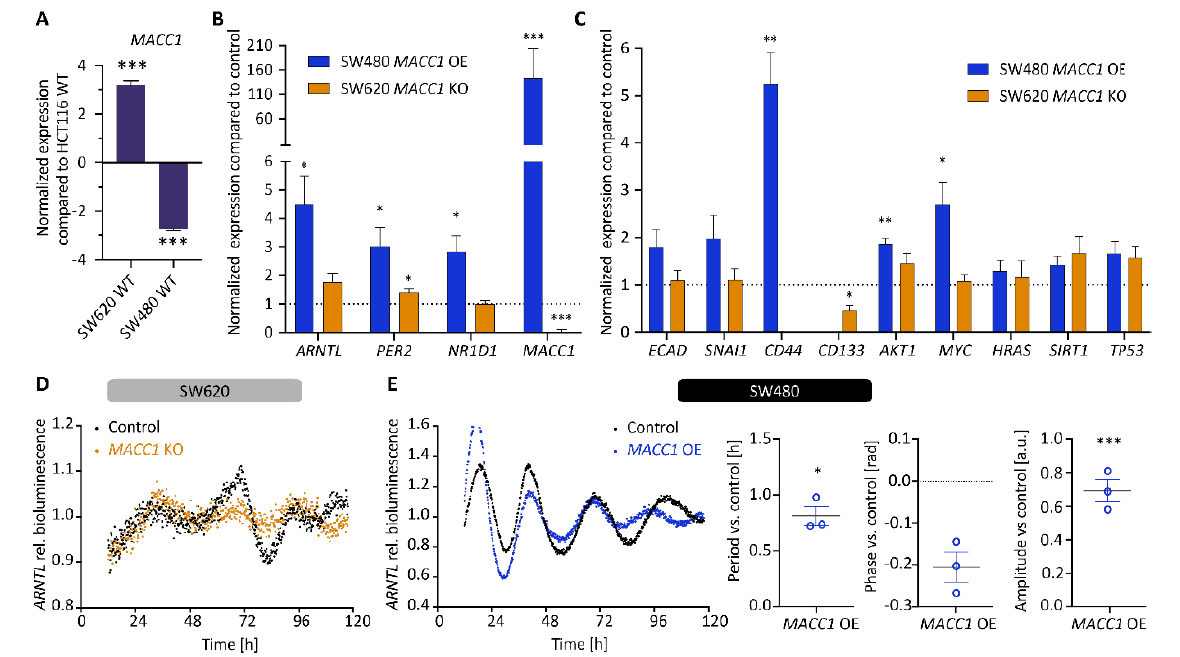
Figure 4. MACC1 manipulation in SW480 and SW620 cell lines leads to differential expression in clock and EMT-related genes ( A ) Analysis of MACC1 expression between HCT116 WT, SW480 WT and SW620 WT ( n = 3, mean ± SEM). Gene expression analysis of core-clock genes ARNTL , PER2 and NR1D1 ( B ) as well as related genes in EMT, cell cycle, death and metastasis ( C ) in SW480 MACC1 overexpressing (OE) and SW620 MACC1 knockout (KO) cells, respectively. Samples were collected at 24 h after synchronization. Each condition was compared with its respective control cell line. ( n = 3, mean ± SEM). ( D , E ) ARNTL -promoter activity in SW620 MACC1 knockout ( D ) and SW480 MACC1 overexpressing ( E ) cell lines compared with the respective control condition. T control = 24.2 ± 0.3 h and T MACC1 OE = 25.0 ± 0.1 h, mean ± SEM. Measurements were made over five days using live-cell bioluminescence readouts. Period, phase and amplitude were measured using Chronostar. ( n = 3, mean ± SEM). * p < 0.05, ** p < 0.01, *** p < 0.001; two-tailed unpaired t